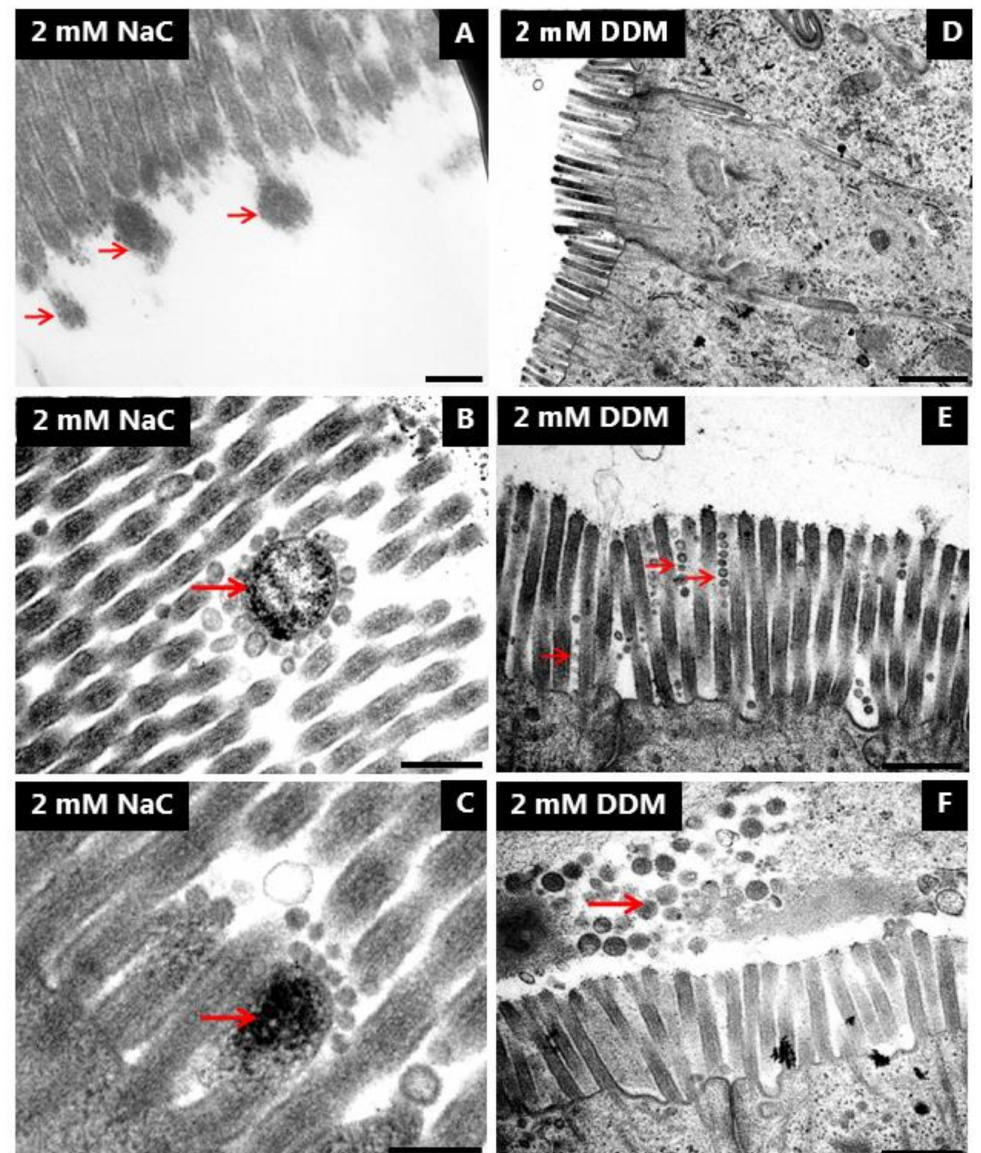
Figure 9. Effects of NaC and DDM on brush border ultrastructure. Electron micrographs showing different lesions in the brush border induced by NaC or DDM. Arrows indicate bulbous protrusions from single microvilli in ( A ), electron dense bodies with small vesicles attached in ( B ) and ( C ), microvesiculated, single microvilli in ( E ) and accumulated cellular debris in the lumen in ( F ). Bars: 0.2 µ m ( A – C ); 1 µ m ( D ); 0.5 µ m ( E , F